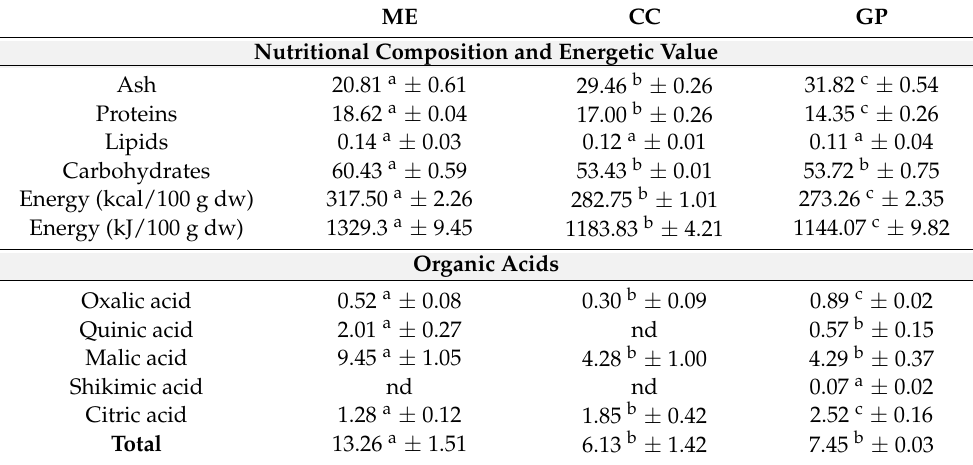
Table 2. Nutritional and chemical composition of dried macroalgae species (mean ± standard deviation (SD)) ( x ± σ